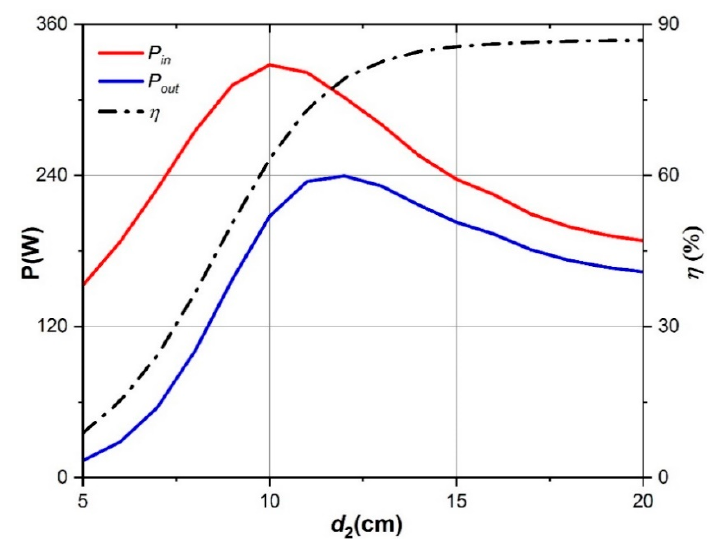
Figure 11. Power transfer and efficiency versus the distance d 2 .